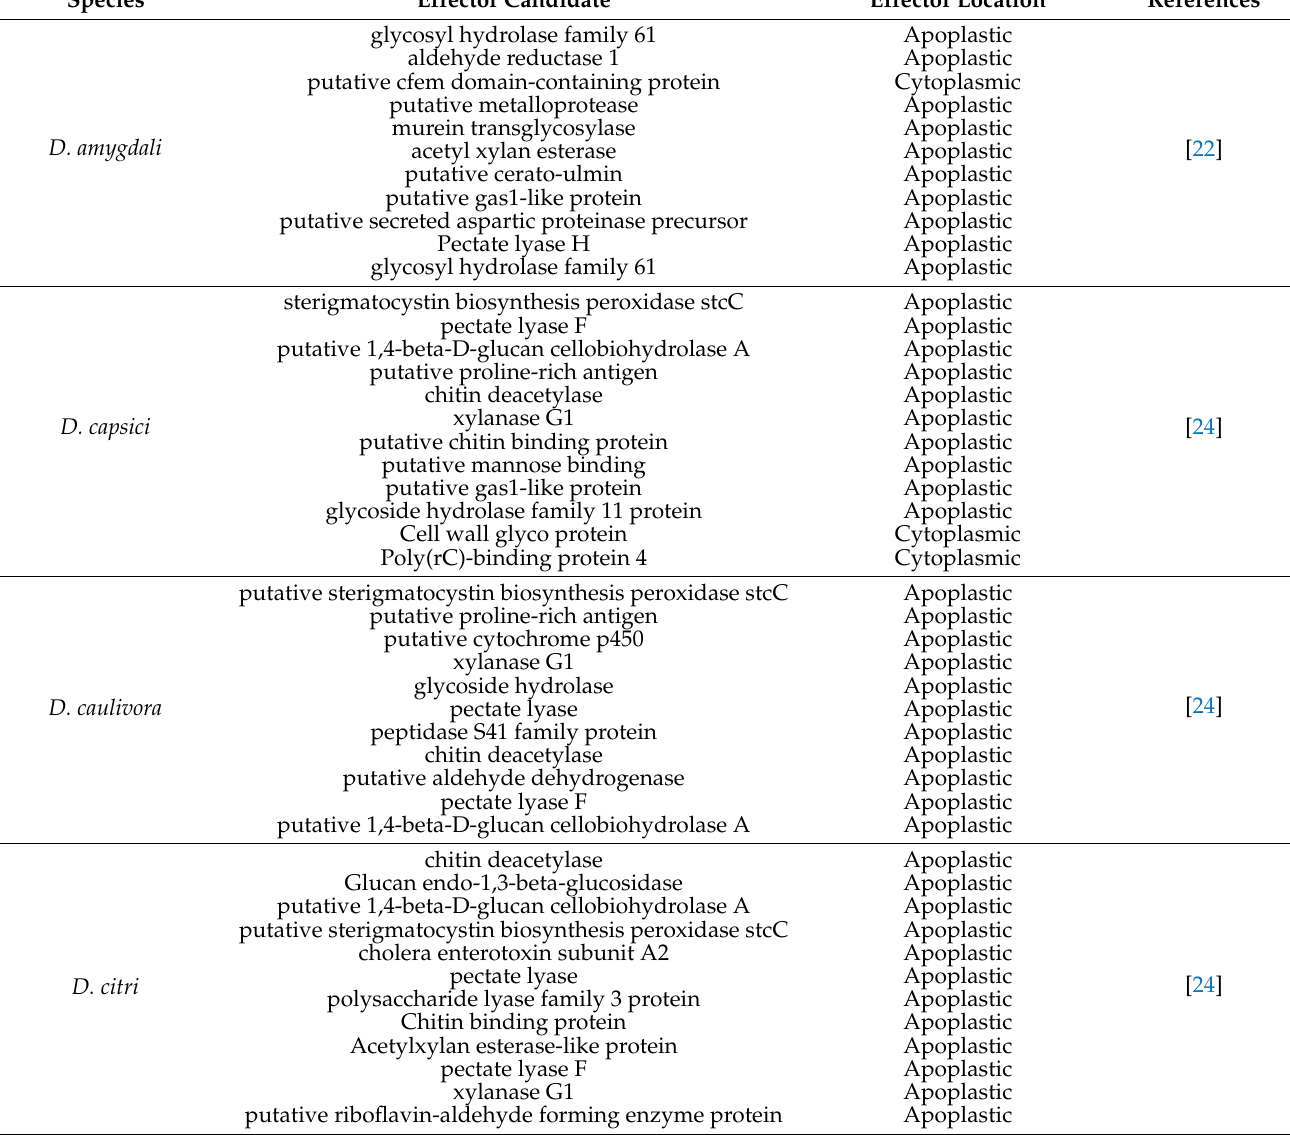
Table 3. Overview of some effector proteins identified in the genomes of species of Diaporthe .